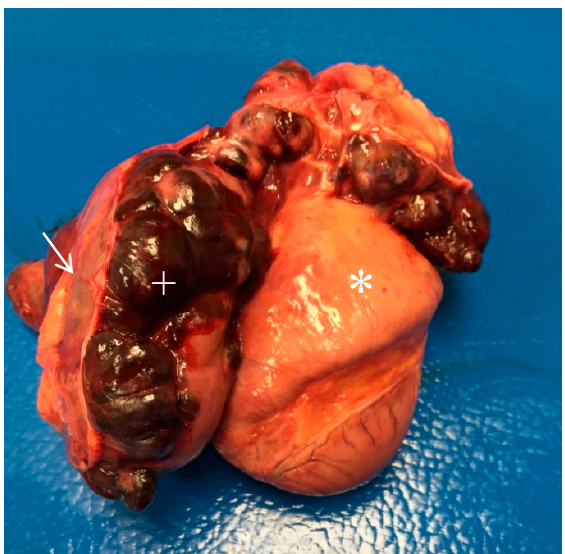
Figure 2. Gross picture of the heart (*) encapsulated by the tumor (+) under the pericardium (arrow).